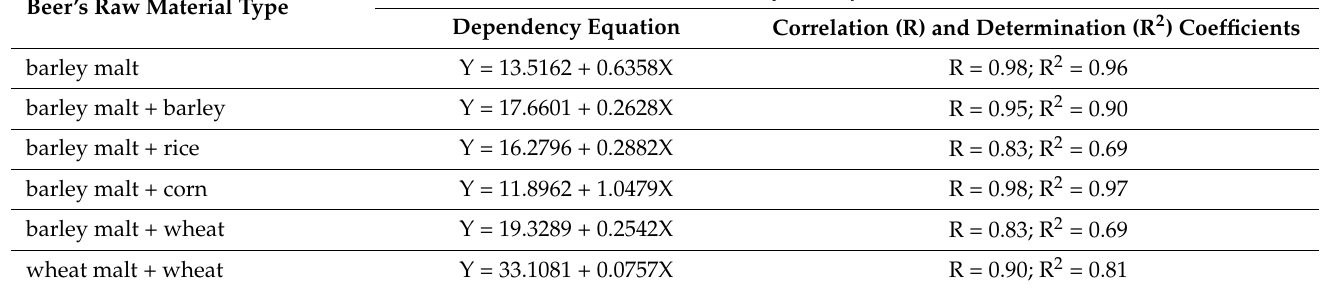
Table 9. The content of iso- α -humulone (Y) on catechins (X) characteristics dependence on the beer’s raw material type.